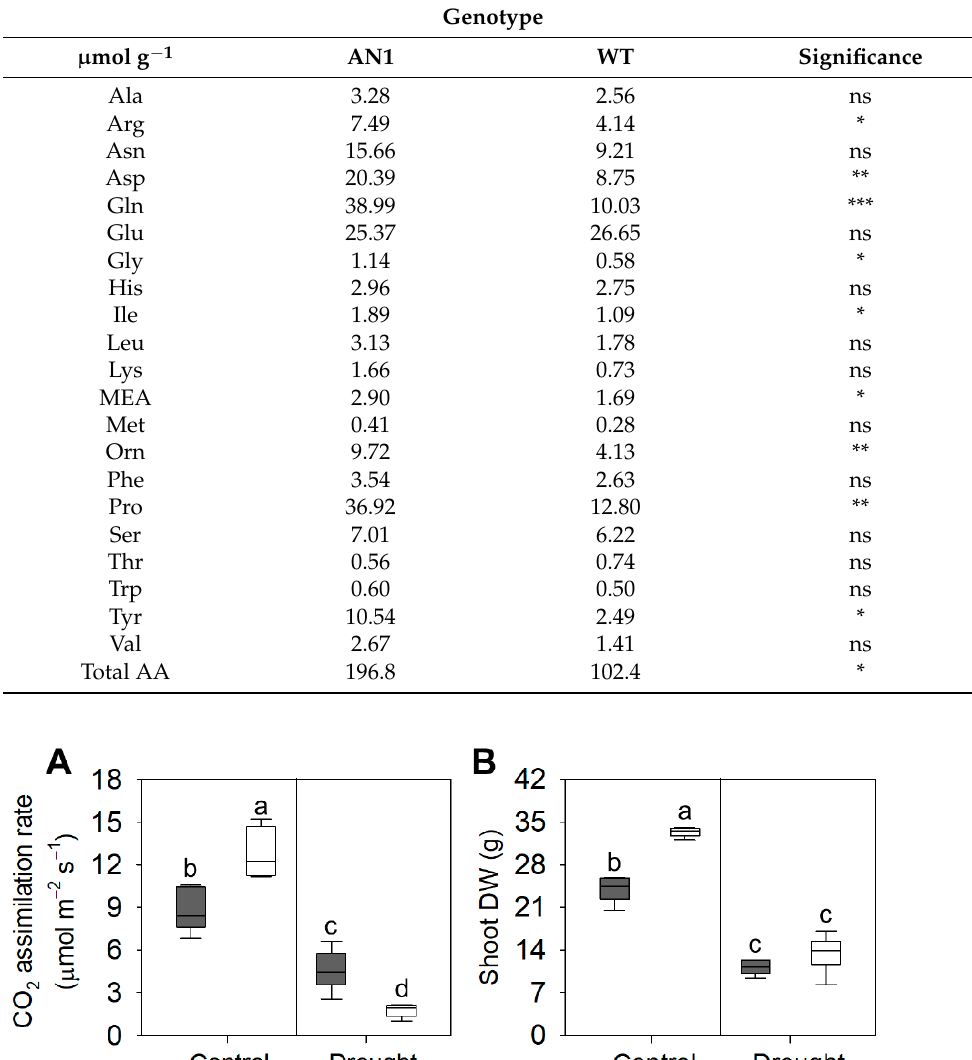
Table 1. Aminoacidic profile in plants carrying p35S: StAN1 (AN1) and wild-type (WT) leaves. Asterisks indicate significant differences according to ANOVA (ns = not significant; * p < 0.05; ** p < 0.01; *** p < 0.001).